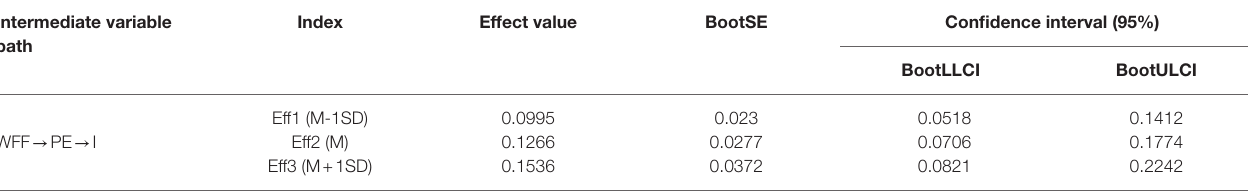
TABLE 7 | Bootstrap analysis of the moderated mediating role (5,000 samples). Intermediate variable